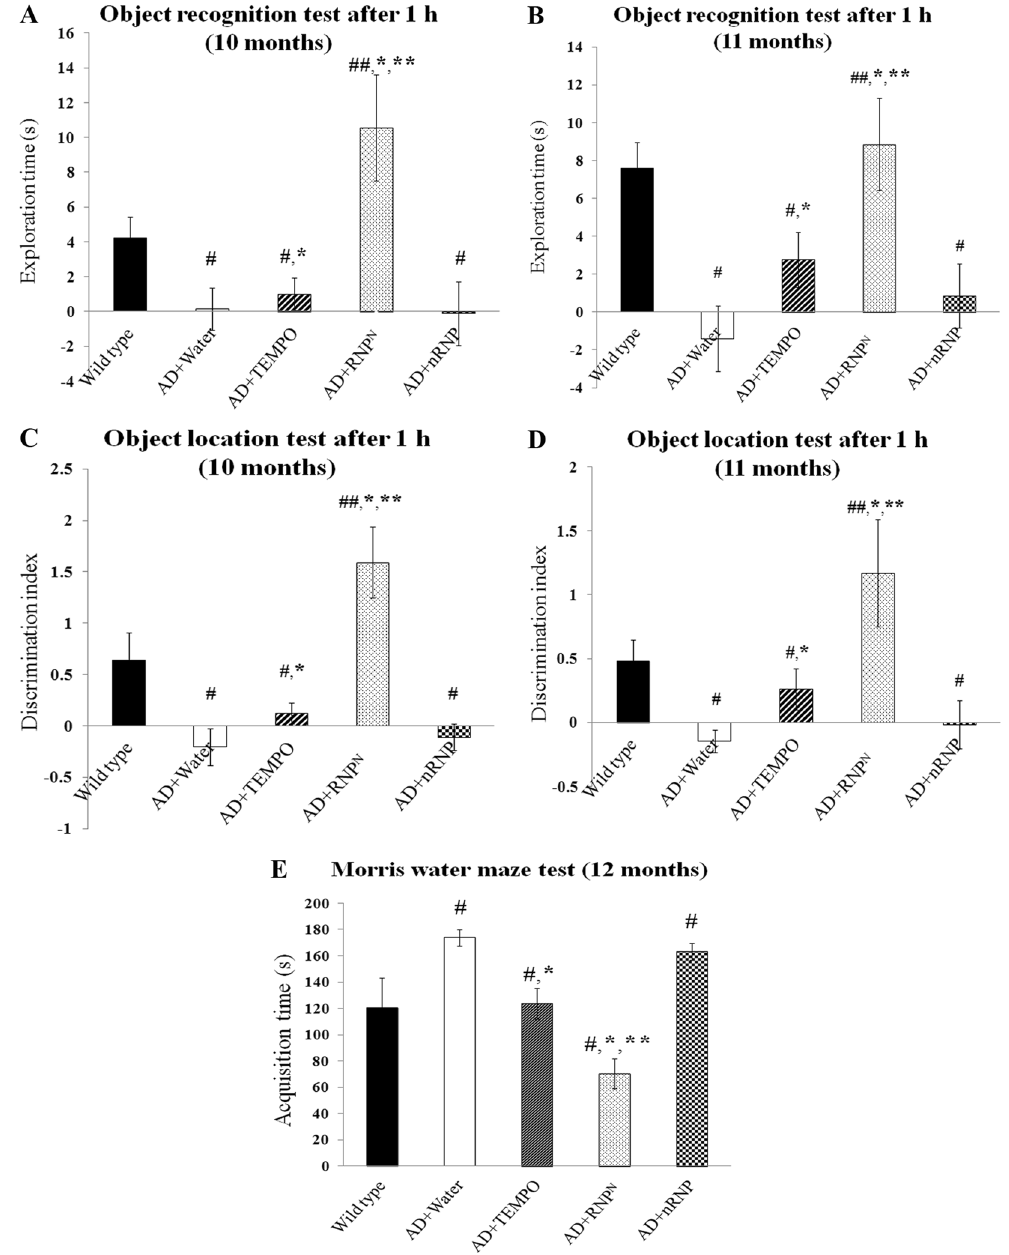
Figure 2. The chronic effect of oral ad libitum RNP N treatment on object recognition test at mice age 10 ( A ) and 11 months ( B ), object location test at mice age 10 ( C ) and 11 months ( D ) after 1 h of administration and Morris water maze test at mice age 12 months ( E ). Data were represented as mean ± SEM, # vs. wild type mice, p < 0.05; ## vs. AD mice treated with TEMPO, p < 0.05; * vs. AD mice treated with water, p < 0.05; ** vs. AD mice treated with nRNP, p < 0.05; n = 10